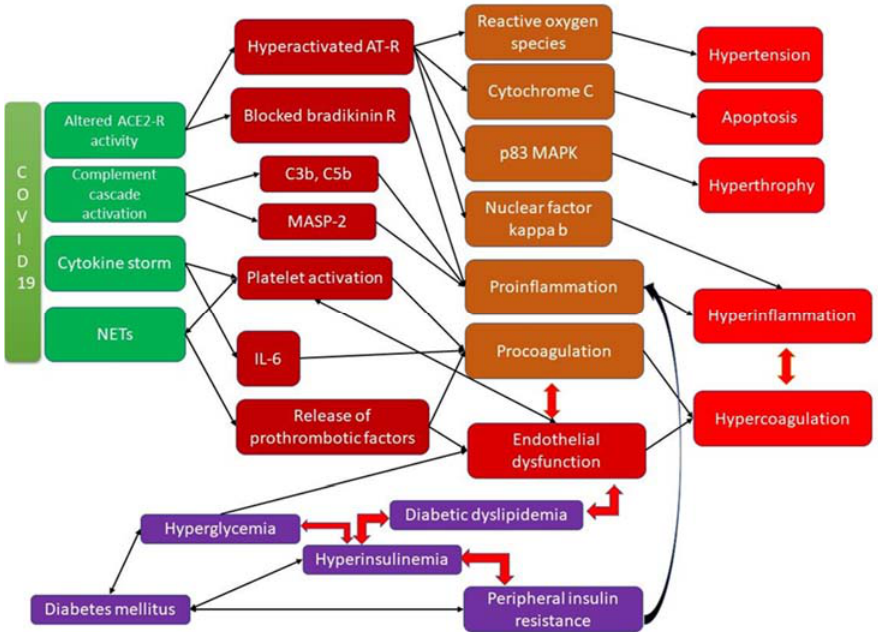
Figure 1. Coagulopathy in DM and COVID-19 infection and the underlying molecular mechanisms.